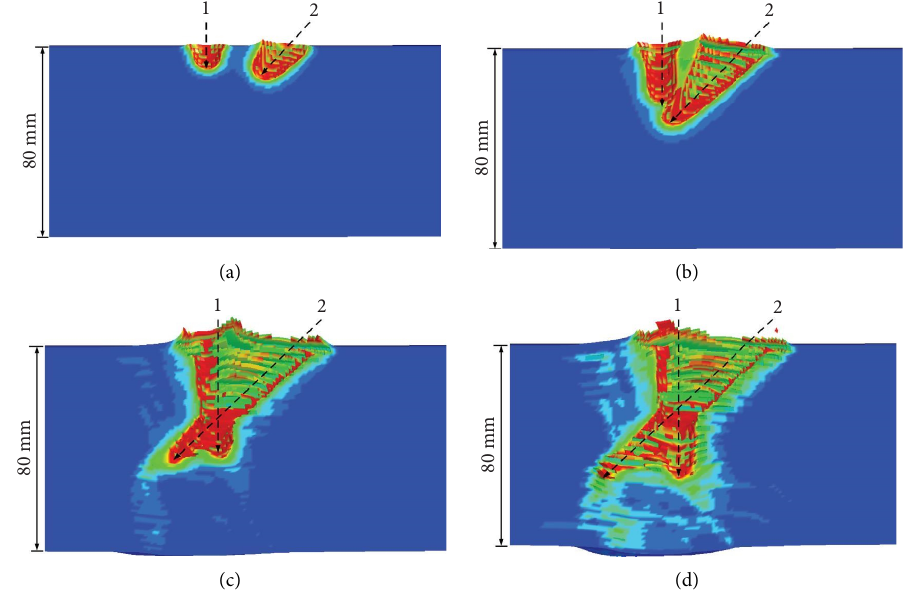
Figure 15: Cloud chart of joint damage strain process in the tunnel area. (a) 0.025ms. (b) 0.075ms. (c) 0.225ms. (d) 0.375ms.